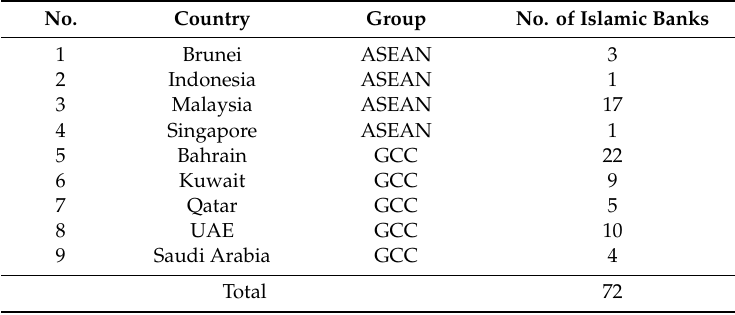
Table A1. Total Number of Islamic banks in ASEAN and GCC